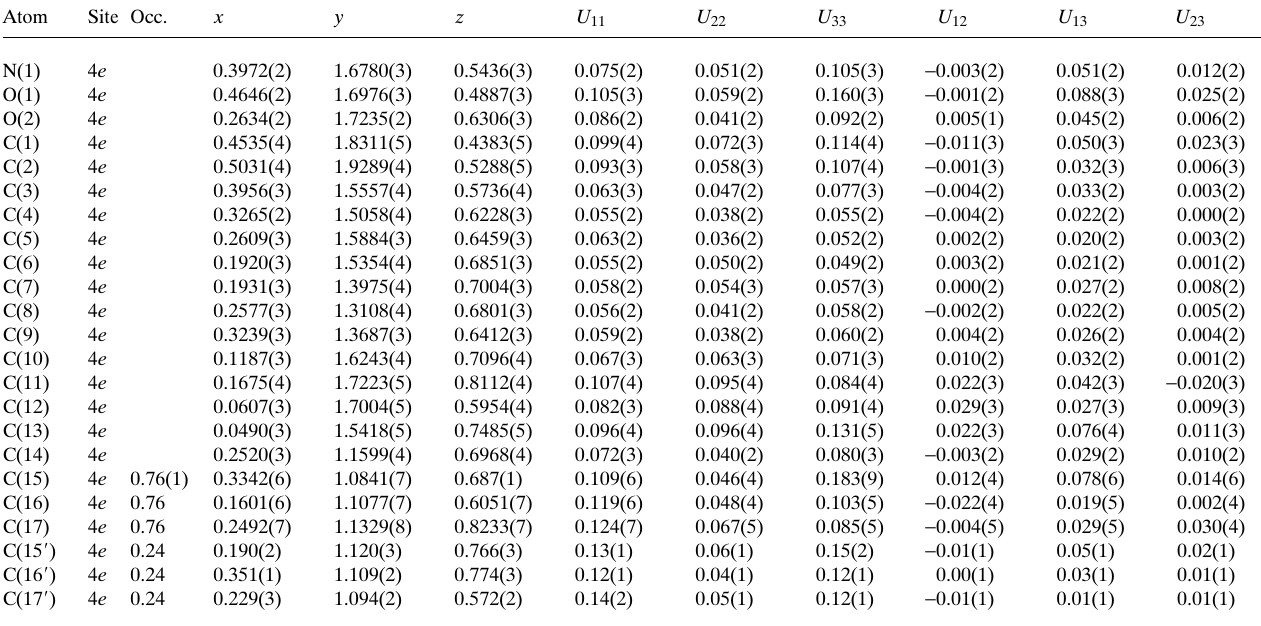
Table 3. Atomic coordinates and displacement parameters (in Å 2 ) .